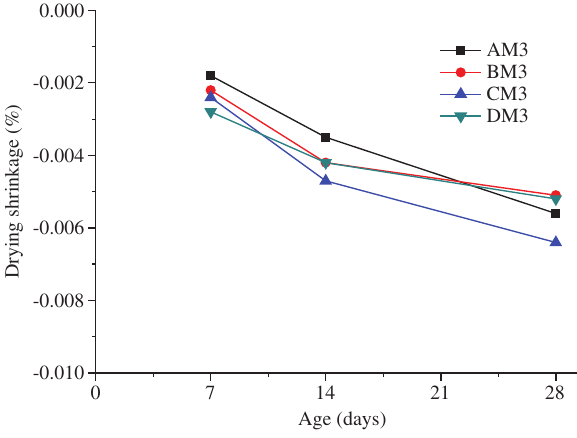
Figure 4: Drying shrinkage of AAFA geopolymer with the alkaline solution/binder ratio of 0.35 vs.